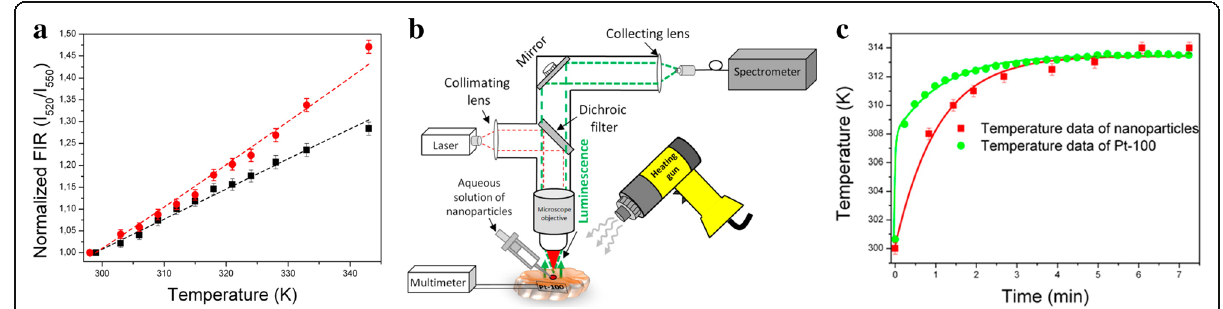
Fig. 22 a I 520 / I 550 with different temperature for Er, Yb:GdVO 4 and Er, Yb:GdVO 4 @SiO 2 . b The sketch map for the ex vivo temperature determination experiment. c The results of the temporal evolution of temperature for the Er, Yb:GdVO 4 @SiO 2 and a thermoresistor Pt-100